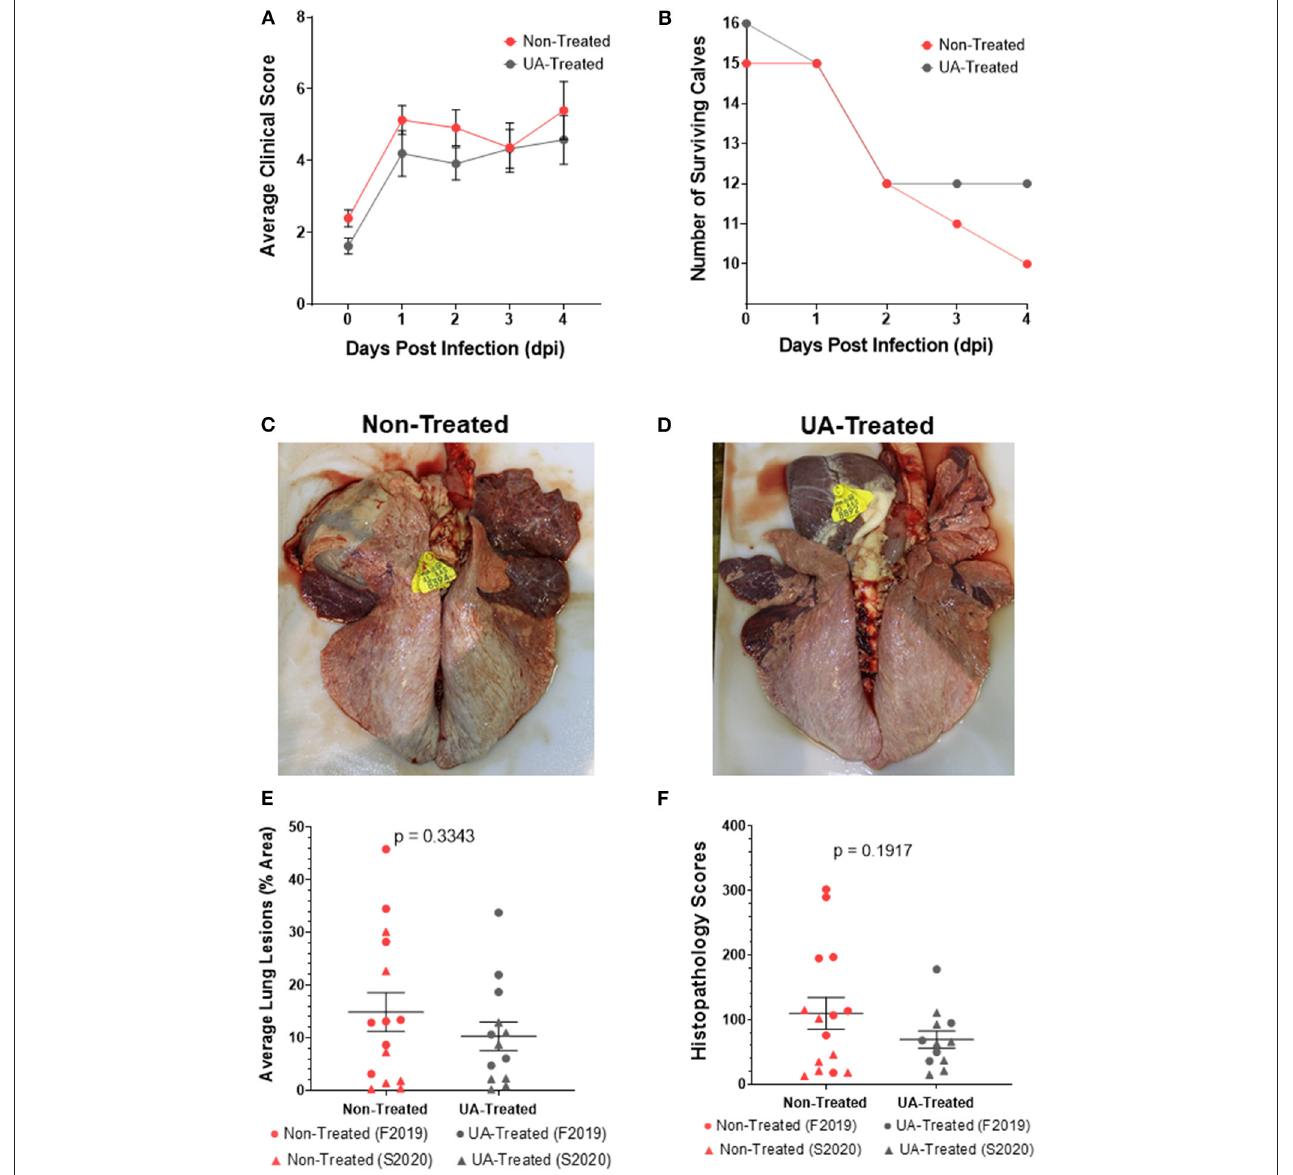
FIGURE 2 | Effects of prophylactic UA treatment on clinical disease and lung lesions following Mannheimia haemolytica infection. In both studies (F2019 and S2020) animals were divided into non-treated and UA-treated groups ( n = 8 calves per group). UA-treated animals were given 1g per head per day of UA powdered supplement with milk feedings beginning 3 days before infection (-3 dpi) and through the duration of the study. Non-treated animals were given no additional supplements with their milk feedings. Animals were challenged through intratracheal instillation with Mannheimia haemolytica ( ∼ 1 × 10 8 each of strains D153 and D174) (0 dpi). (A) Calves were monitored and scored daily using a modified Wisconsin scoring system. The data depict the average daily clinical score ± SEM pooled from both studies ( n = 15 per group). The data were analyzed by two-way ANOVA mixed-effects model with multiple comparisons. (B) Calves were removed from their respective studies upon reaching a humane endpoint, and the number of surviving calves in each treatment group were charted over the 4 day challenge period. (C) Representative image of a non-treated lung (S2020) at 4 dpi. (D) Representative image of a UA-treated lung (S2020) at 4 dpi. (E) At necropsy, lungs were photographed and scored based on the percentage of that area that was affected with pneumonic consolidation. Individual animal data from F2019 has been represented as a circle, while S2020 animal data has been represented as a triangle. This figure shows the average lung consolidation ± the SEM for each treatment group (non-treated n = 15, UA-treated n = 13); the data were analyzed using a standardized unpaired t -test. (F) Samples from each lung were collected and submitted to a blinded pathologist for scoring as described in McGill et al. (9). Individual animal data from F2019 has been represented as a circle, while S2020 animal data has been represented as a triangle. The graph depicts the mean histopathology ± SEM for each treatment group (non-treated n = 15, UA-treated n = 12). Outliers in the data were first identified using the ROUT method (Prism v9.1.0), and the data was subsequently analyzed using a standardized unpaired t -test to determine significant differences between the two